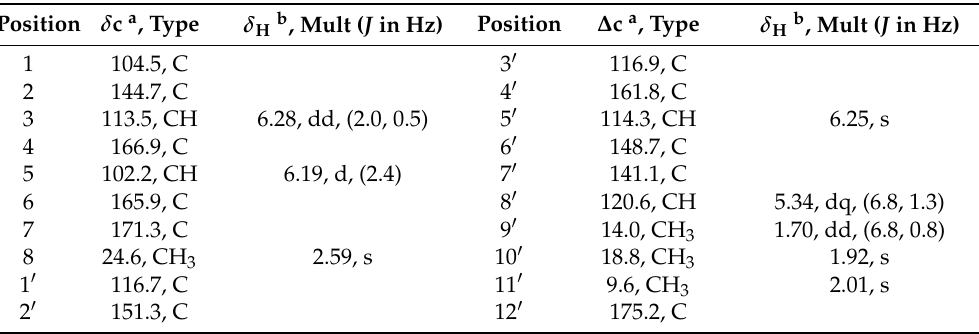
Table 1. NMR data for 1 measured in CD 3